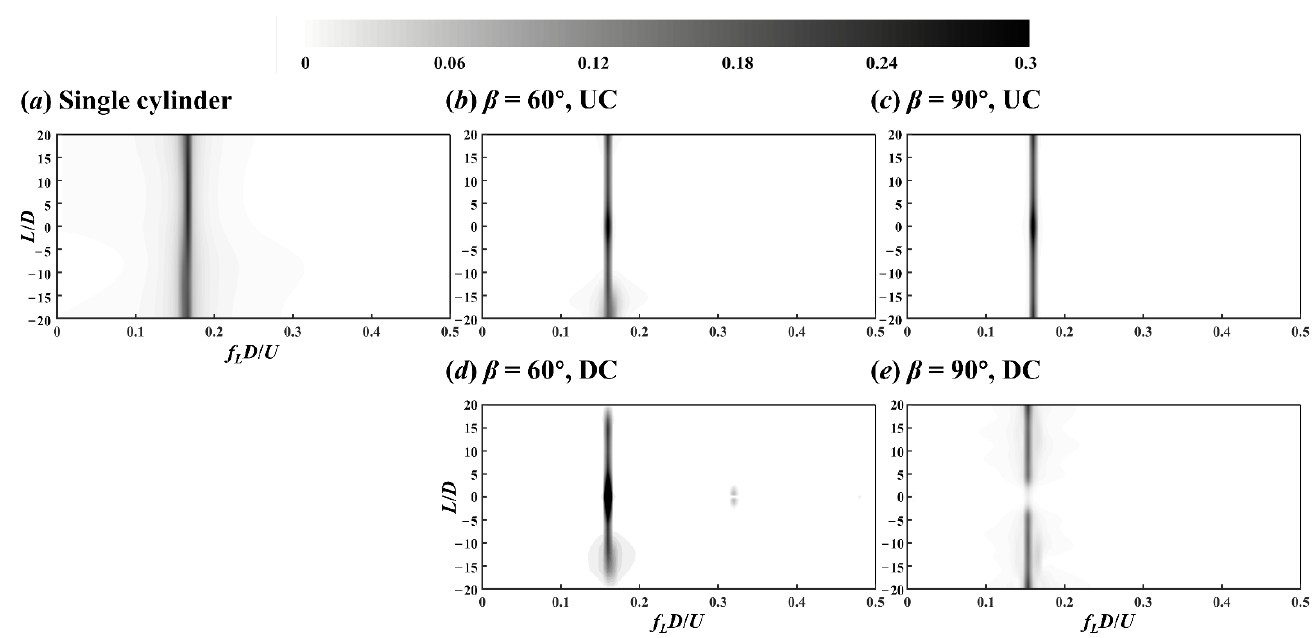
Figure 5. Contours of PSD calculated by sectional lift coefficient along the single cylinder ( a ), and UC ( b , c ) and DC ( d , e ) in 60° (middle) and 90° (right) arrangements.